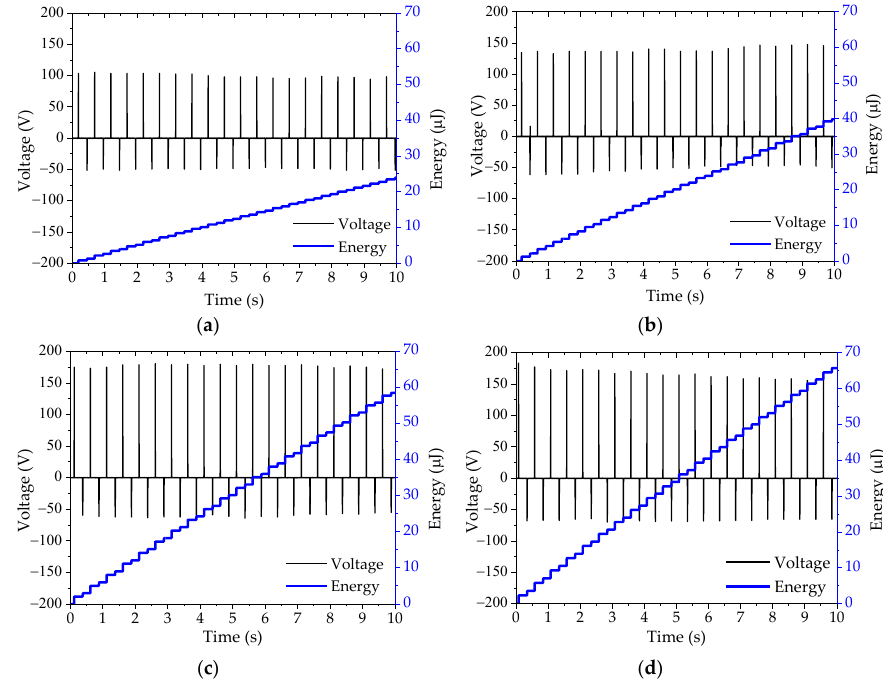
Figure 10. Output voltage and energy curve of TEH across the optimal load under 2 Hz with varying gap width; ( a – d ) are of 1 mm to 4 mm gap width in an increment of 1 mm.